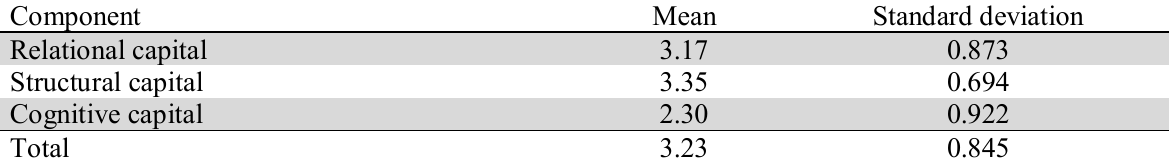
Mean and standard deviation of different components of social capital Component